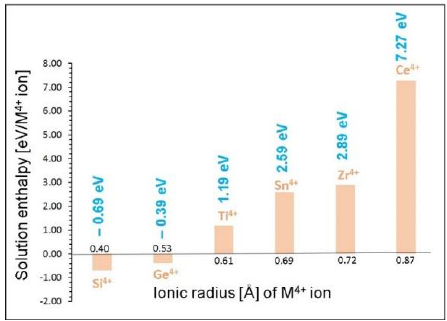
Figure 7. Enthalpy of solution of MO 2 , (M = Si, Ge, Ti, Sn, Zr and Ce) with respect to the M 4 + ionic radius in Mg 6 MnO 8 .